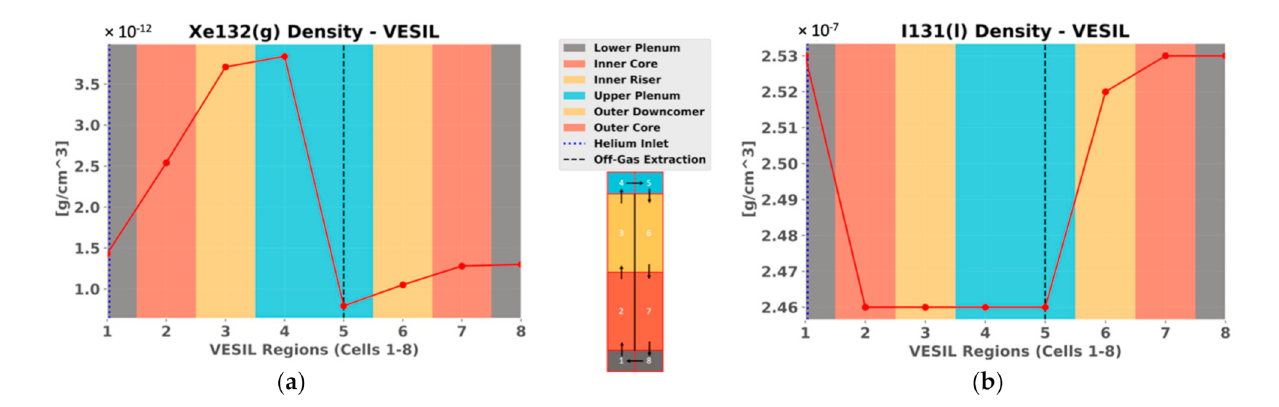
Figure 5. ( a ) 132 Xe( g ) in He bubble (g/cm 3 ); ( b ) 131 I( l ) in fuel-salt (g/cm 3 ).